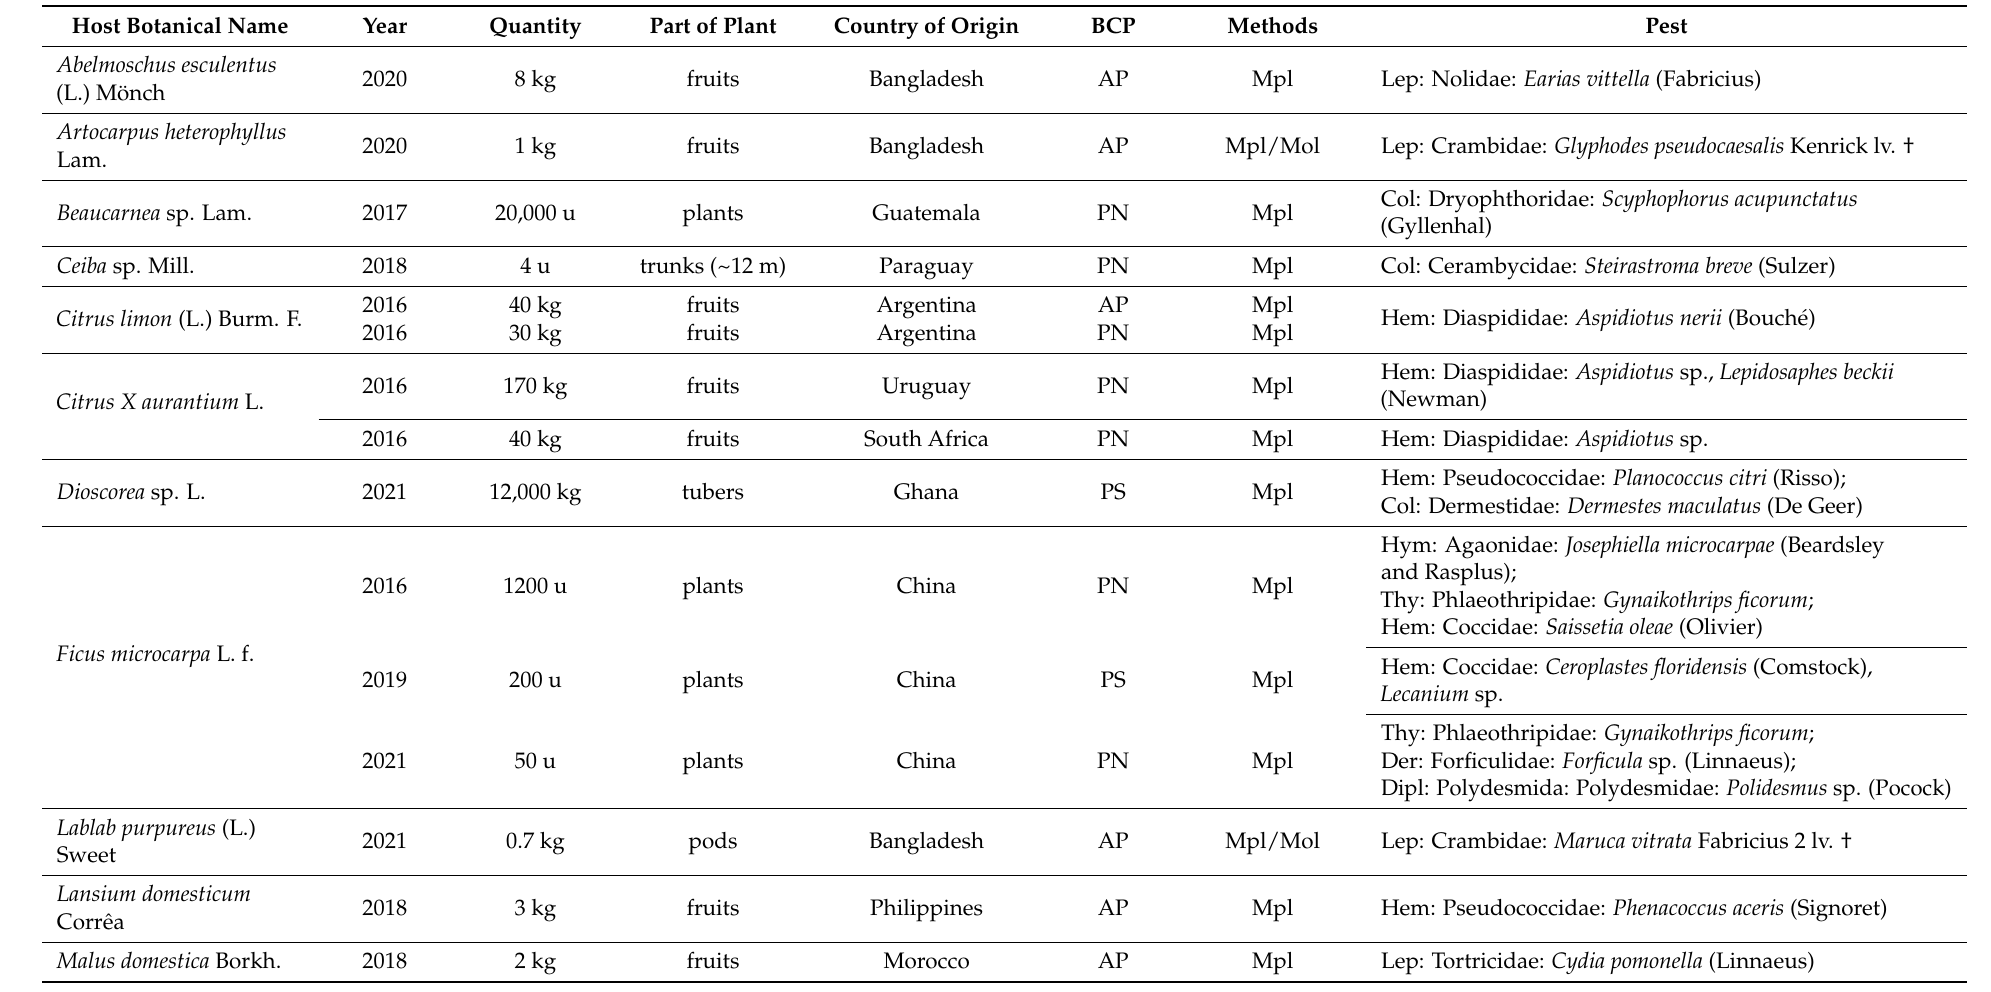
Table 2. Main pests and relative hosts detected during inspections at BCPs of Campania Region. u, unit; AP, International Airport of Naples; PN, Port of Naples; PS, Port of Salerno; Mpl, morphology; Mol, molecular. Col, Coleoptera; Hem, Hemiptera; Lep, Lepidoptera; Thy, Thysanoptera; Hym, Hymenoptera; Dip, Diptera;